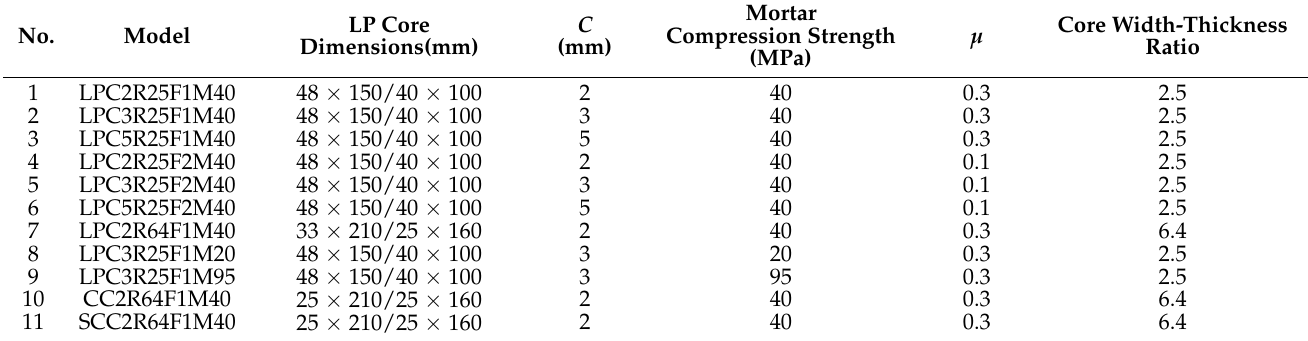
Table 1. The LPBRB numerical models’ geometries and specifications.